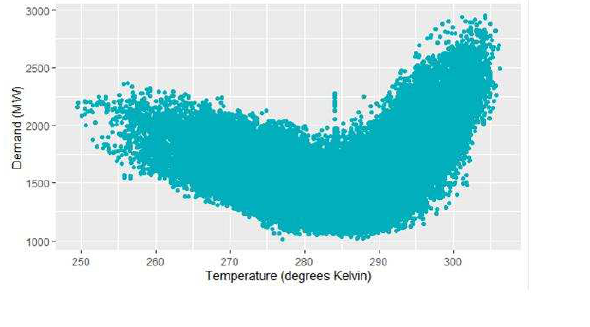
Figure 2: Temperature effect on the energy consumption